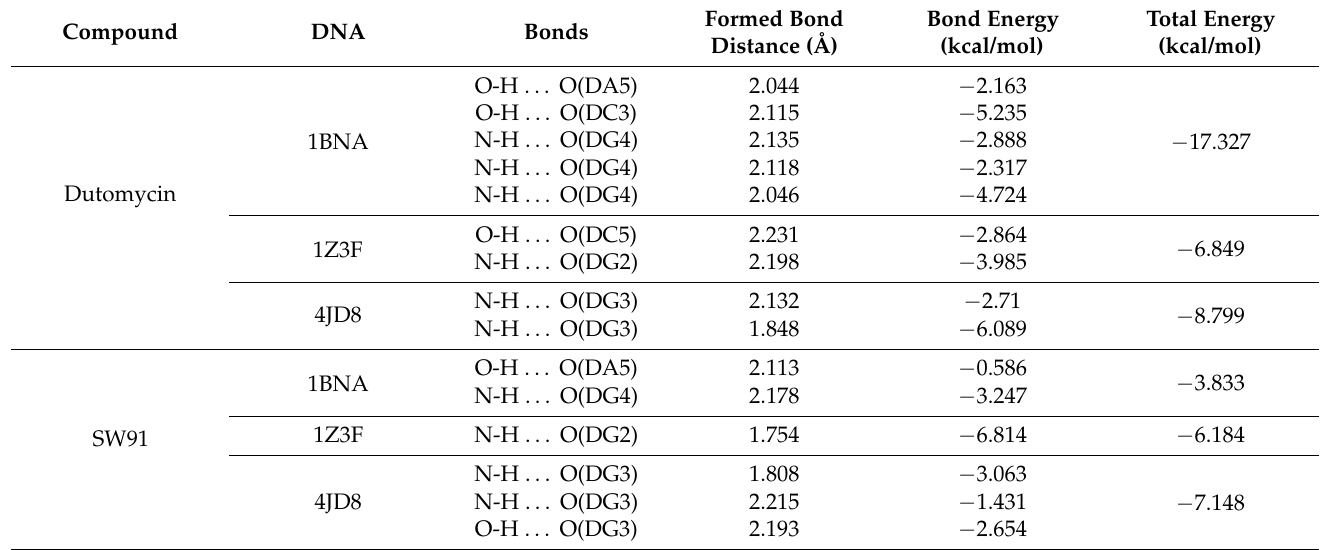
Figure 9. Computational docking model DNA (DNA model with gaps): ( a ) binding mode of duto- mycin to DNA (PDB ID 1Z3F); ( b ) hydrogen bond position and distance between dutomycin and